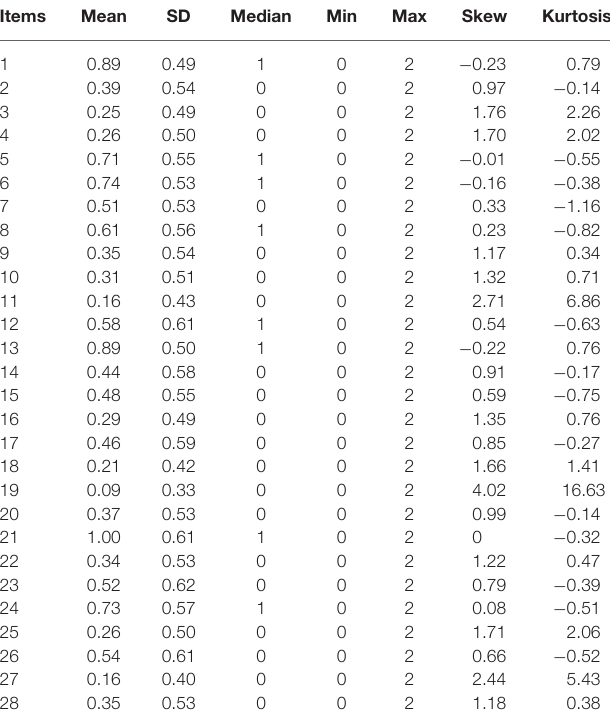
TABLE 2 | Descriptive statistics of individual items of everyday memory questionnaire